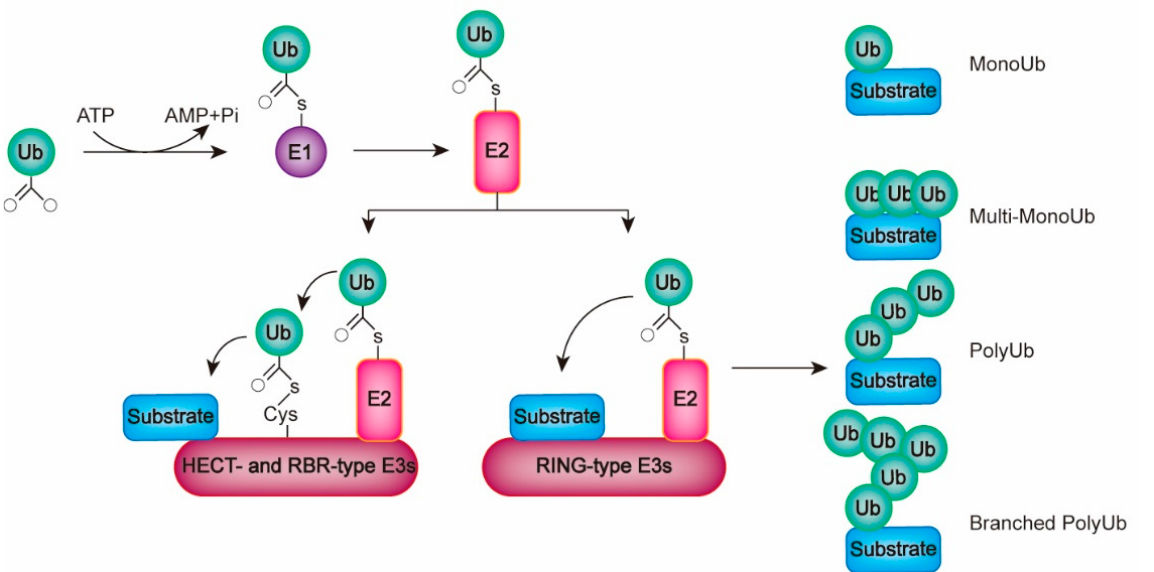
Figure 1. The ubiquitination machinery. Ubiquitination is achieved through the sequential activity of E1, E2, and E3. RING-type E3s can mediate a direct ligation of Ub from E2s to substrates, whereas HECT-/RBR-type E3s require two-step reactions. Typical types of Ub linkages include MonoUb, multi-MonoUb, poly-Ub, and branched poly-Ub.